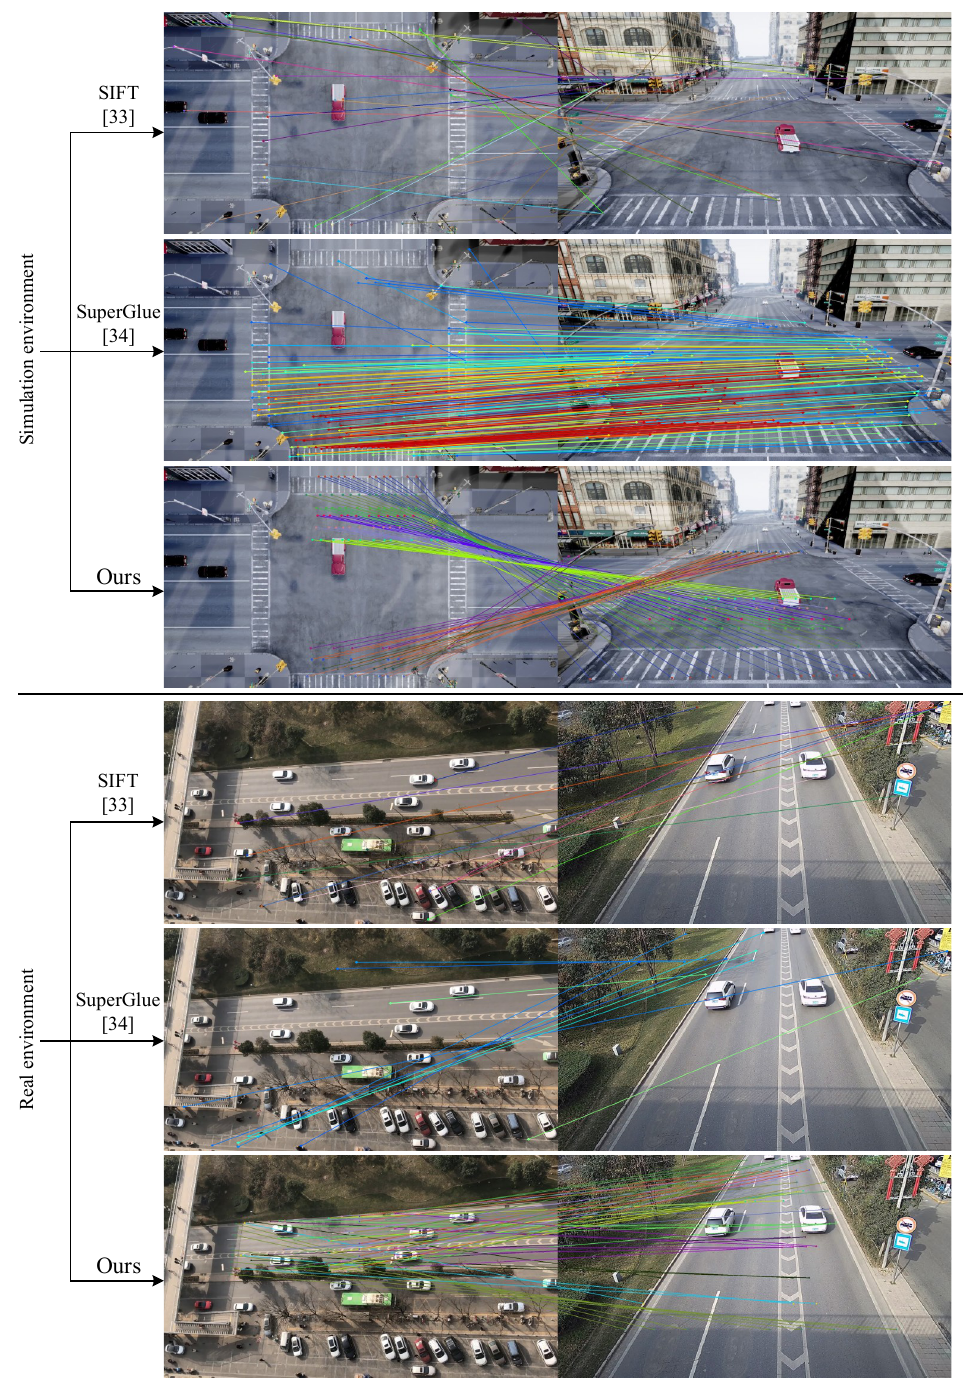
Figure 12. Qualitative cross-view matching comparison of our proposed method against SIFT and SuperGlue. The air-to-ground matching pairs between UAV aerial image and the ground monitoring image are connected by straight